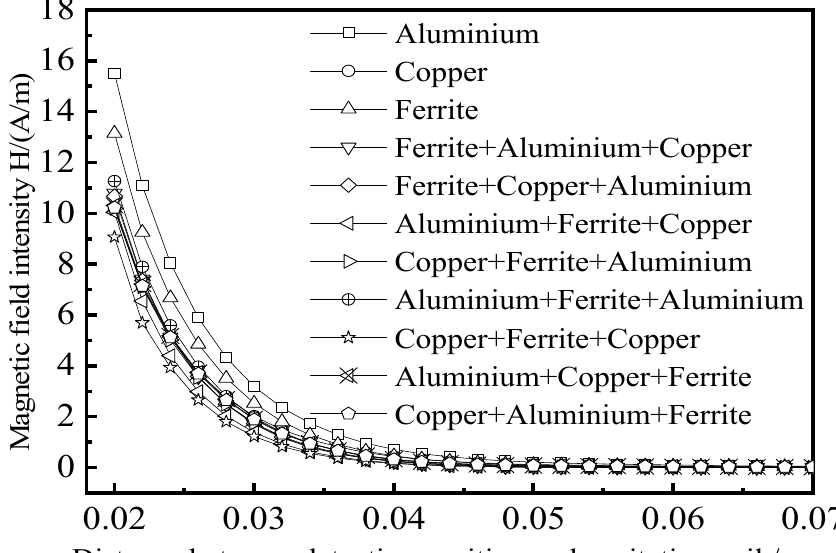
Figure 10. The influence of shielding material on direct coupling magnetic field.